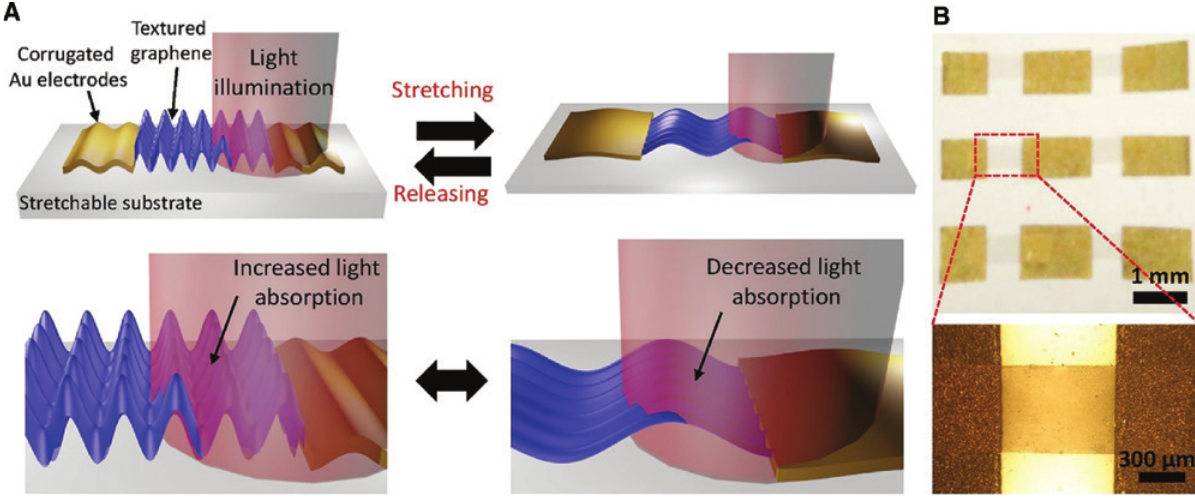
Figure 1: Mechanism of enhanced and strain-tunable photoresponsivity and photographs of textured graphene PD arrays. (A) Schematic illustrations of the physical mechanism enabling enhanced and strain-tunable photoresponsivity. Bottom schematic illustrations show close-up at the interface and illustrate the modulation of crumple areal density, height, and pitch in the illuminated region with an applied strain. (B) Photograph of a stretchable PD array (3*2 array). Bottom image shows an optical microscope image of the textured graphene PD. Reproduced with permission from Ref. [14].